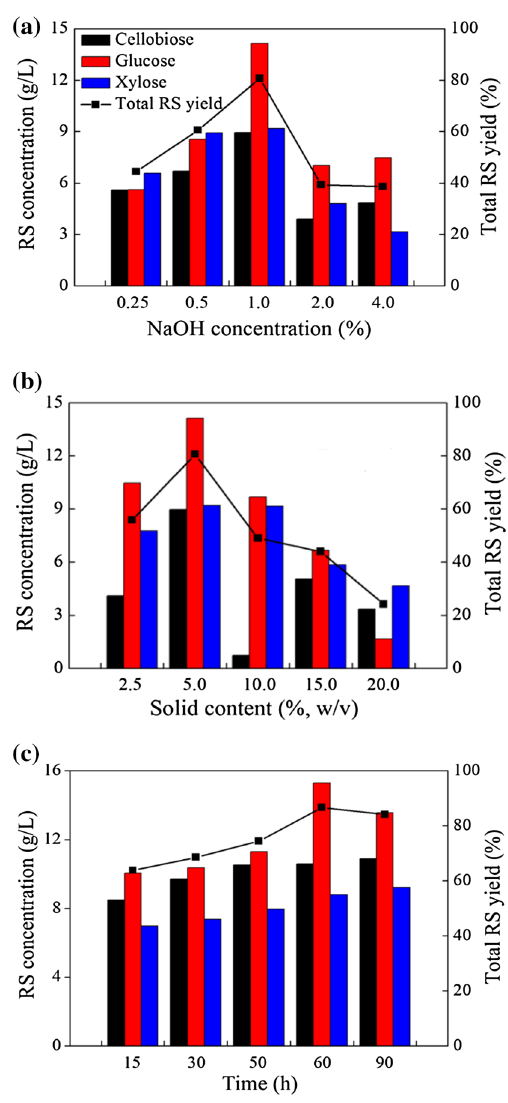
Figure 1. ( a ) RS yield after 96 h of the enzymatic hydrolysis of the WS pre-treated with different concentrations of NaOH ranging from 0.25% (w/w) to 4.0% (w/w). NaOH pre-treatment conditions: temperature, 121 °C; solid content, 5.0% (w/v); and time, 50 min; ( b ) RS yield after 96 h of the enzymatic hydrolysis of the WS pre-treated with 1.0% (w/w) NaOH at different solid contents ranging from 2.5% (w/v) to 20.0% (w/v). NaOH pre- treatment conditions: temperature, 121 °C; NaOH concentration, 1.0%; and time, 50 min; ( c ) RS yield after 96 h of the enzymatic hydrolysis of the WS pre-treated with 1.0% (w/w) NaOH for different times ranging from 15 to 90 min. NaOH pre-treatment conditions: temperature, 121 °C; NaOH concentration, 1.0%; and solid content, 5.0%